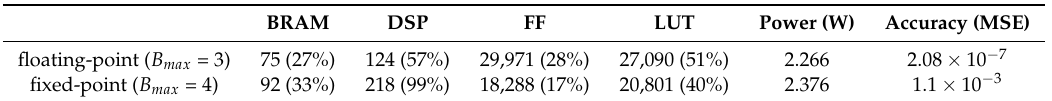
Table 3. Vivado implementation of PCA accelerator on Zedboard for HI data, bands = 12, accuracy is compared with MATLAB.